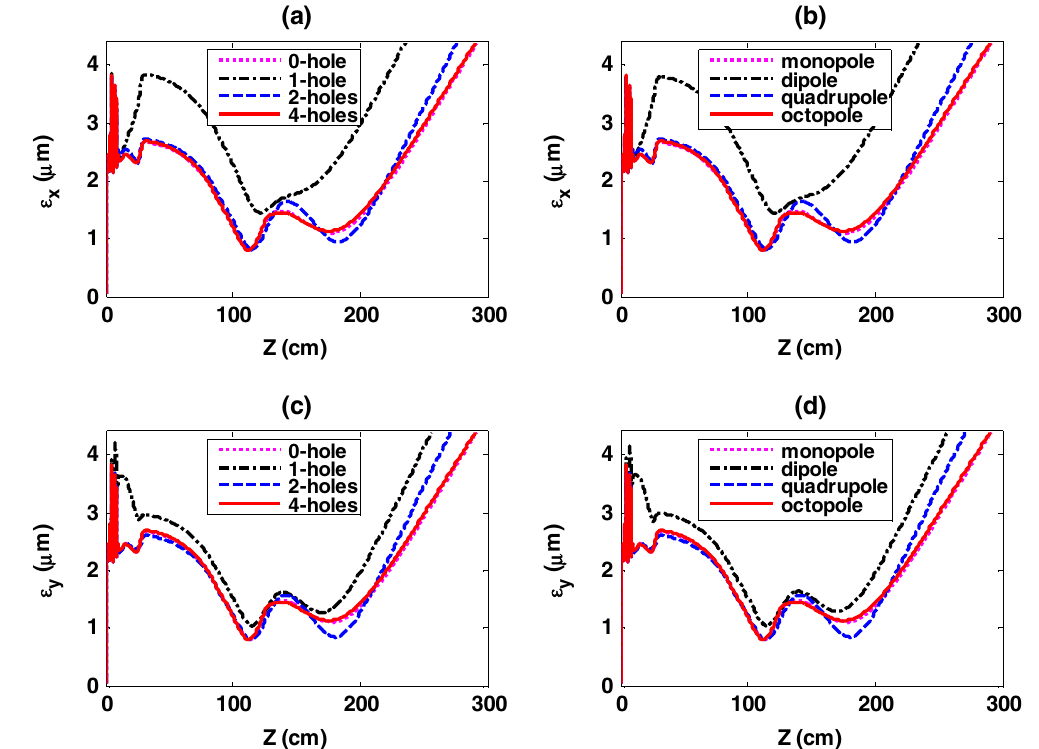
FIG. 11. Simulation results of rms emittance in both directions without solenoid field for the beam charge of 1 nC. (a) Emittance evolutions in the horizontal ( x ) direction for each model. (b) Emittance evolutions from the dominant multipole field from each model in the horizontal ( x ) direction. (c) Emittance evolutions in the vertical ( y ) direction for each model. (d) Emittance evolutions from the dominant multipole field from each model in the vertical ( y )